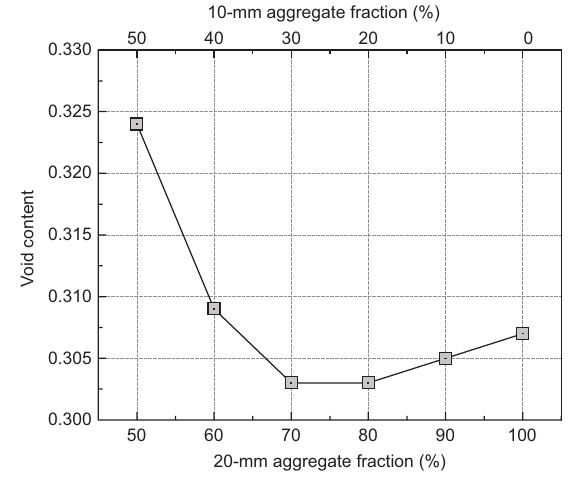
Figure 1 Void content.